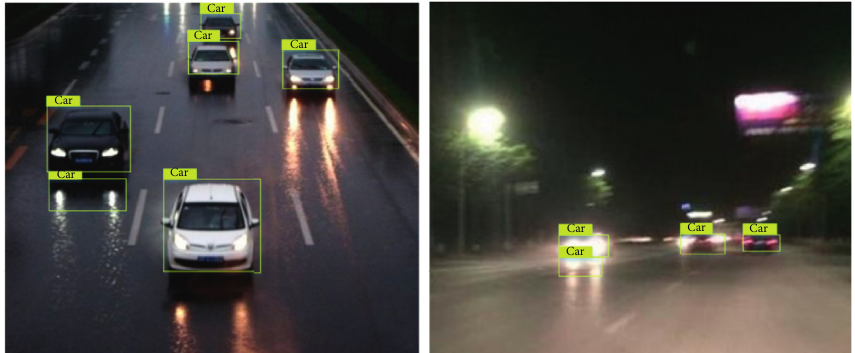
Figure 2: The results of car detection based on VIDAR on reflection